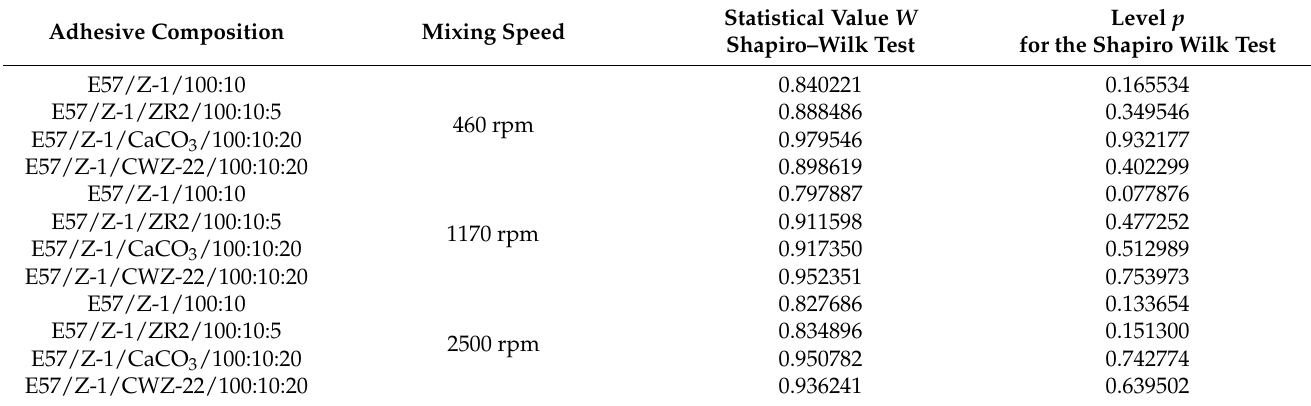
Table 5. Results of the Shapiro–Wilk tensile strength test of adhesive compositions grouped by mixing speed. Adhesive Composition